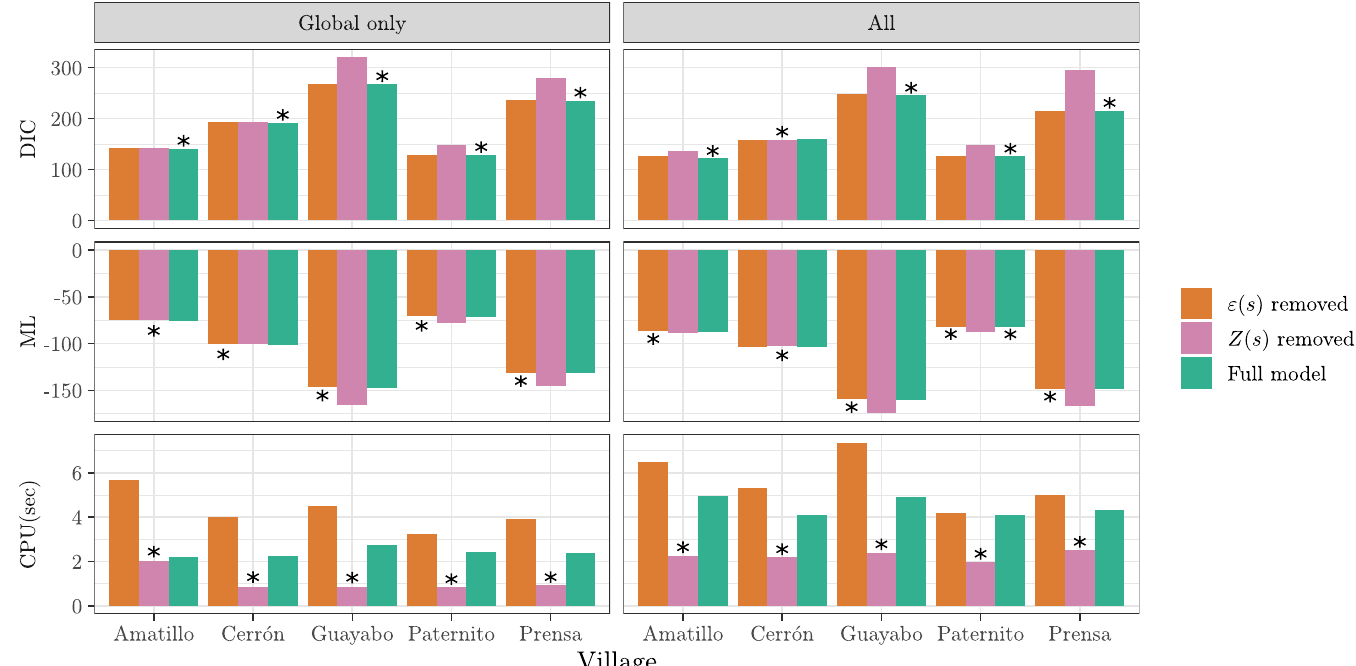
Fig 1. Model comparison based on two goodness-of-fit measures and computation time, by village and level of covariate information. The best-performing model is indicated with a star in each case. “Global only” means only covariates available from the coordinates are available, and “All” indicates all 28 covariates were used. “ Z ( s ) removed” refers to the model outlined in Sec. 2.2 but with no spatial effects, “ ε ( s ) removed” refers to the independent effects removed, and “Full model” refers to the full model. DIC and ML are defined in S1 Appendix.